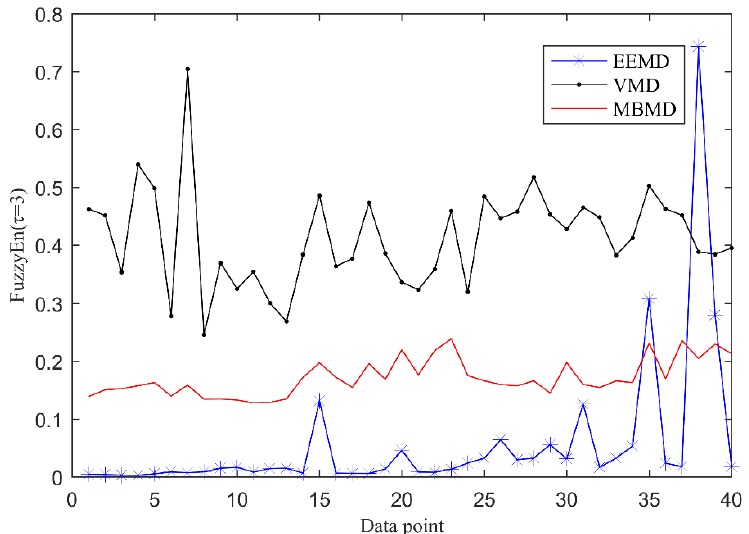
Figure 27. MBMD, VMD, EEMD comparison diagram of the harmonic signal plus the pulse signal.